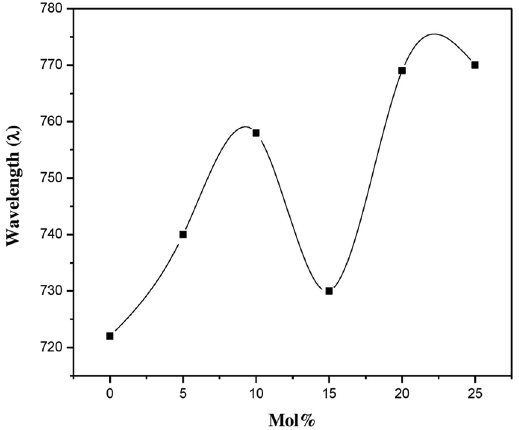
Figure 7: The compositional mole% as a function of peak position (λ).